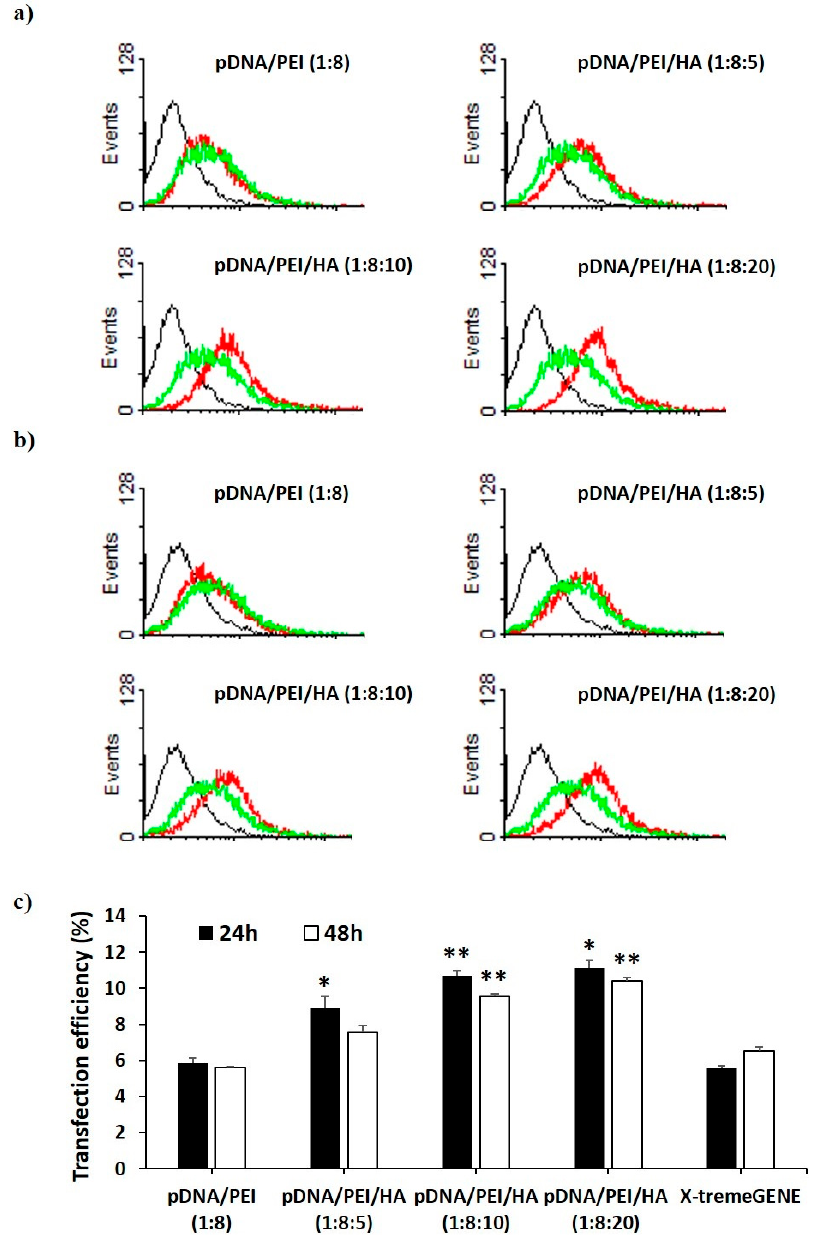
Figure 5. Flow cytometry profiles of non-transfected hASCs ( black ) and hASCs transfected with pCXLE-EGFP using each nanocomplex ( red ) and X-tremeGENE ( green ) ( a ) at 24 h and ( b ) 48 h after treatment. Black line = control, red line = complex, green line = X-tremeGENE; ( c ) Percentage of EGFP-expressing hASCs after transfection by each nanocomplex. Data are presented as means ± S.E. ( n = 4), * p < 0.05, ** p < 0.01 vs. X-tremeGENE.